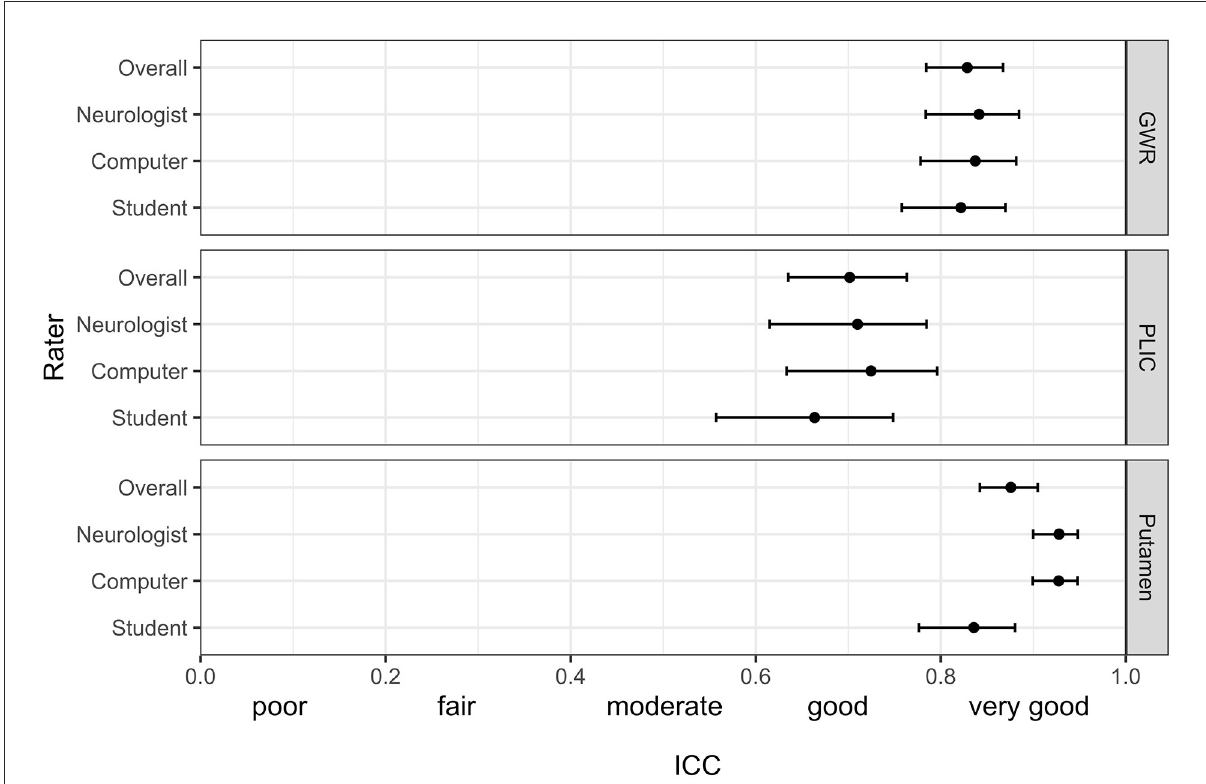
FIGURE2 Intraclass correlation (ICC) (95% CI) for the pairwise agreement of three different raters with the study neuroradiologist in GWR and ROI assessment (Putamen and PLIC) in Hounsfield Units (HU) in CTs after cardiac arrest.